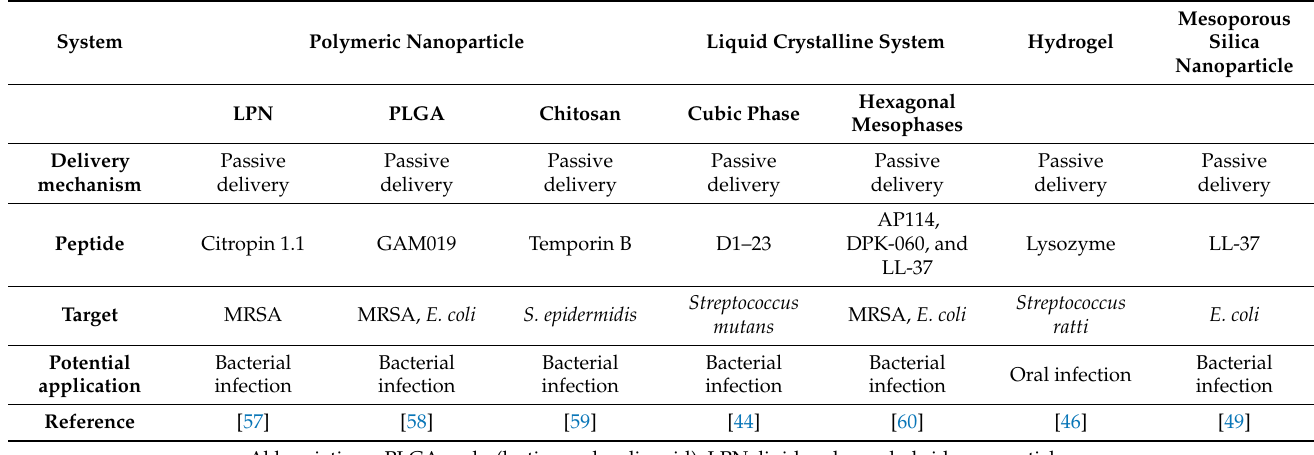
Table 2. An overview of AMPs contained in nanodrug delivery systems composed of polymeric nanoparticles, liquid crystalline systems, and mesoporous silica nanoparticles and their potential applications.